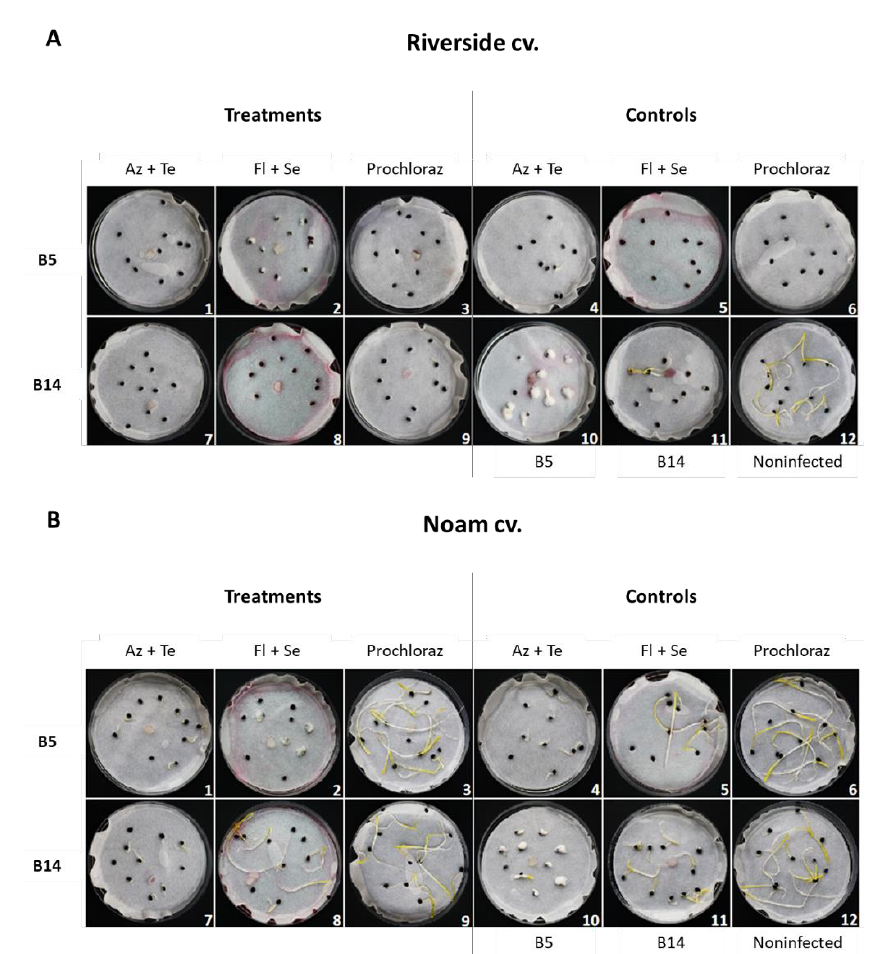
Figure 7. Image of the seeds’ pathogenicity assay for the Riverside cv. ( A , Orlando) and the Noam cv. ( B ). The experiment and abbreviations are depicted in Figure 4. Treatments: A combination of phytopathogens infection and chemical seed coating (1 – 3 — Fusarium acutatum , isolate B5; 7 – 9 — Fusarium oxysporum f. sp. cepae , isolate B14). Controls: Seeds without chemical coating and pesticide (12, Noninfected), non-inoculated seeds with selected fungicides (4 – 6), and inoculated seeds without pesticide (10 – 11).